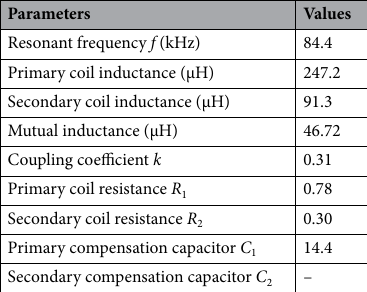
Table 1. System parameters.